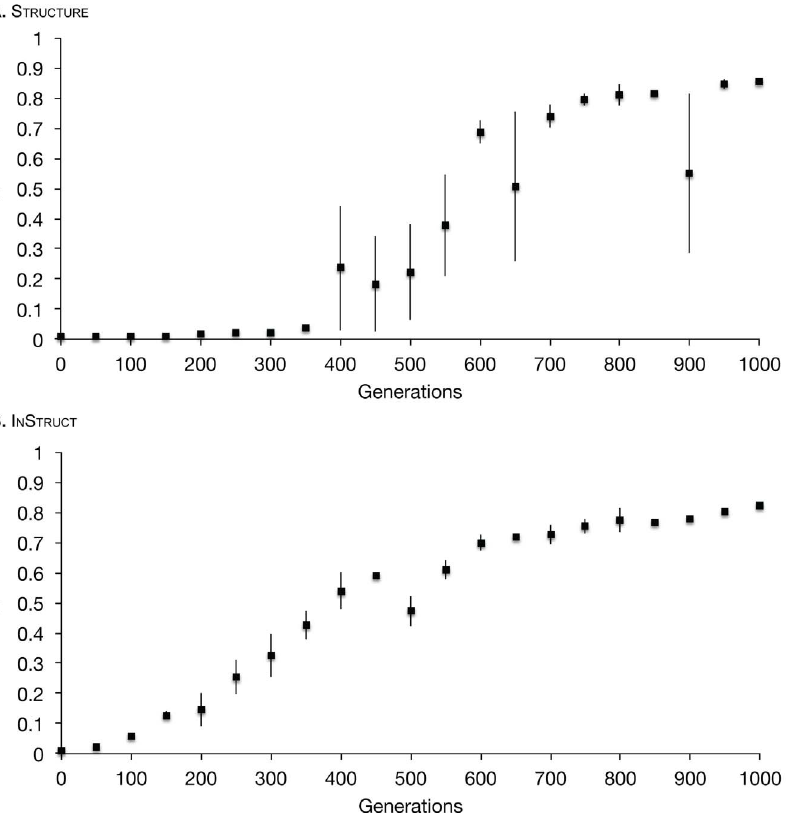
Figure 1. Change in population structure over 1,000 generations of simulated population divergence as inferred by (a) S TRUCTURE and (b) I N S TRUCT . Error bars denote the standard error of three separate simulations for each sampling time point.